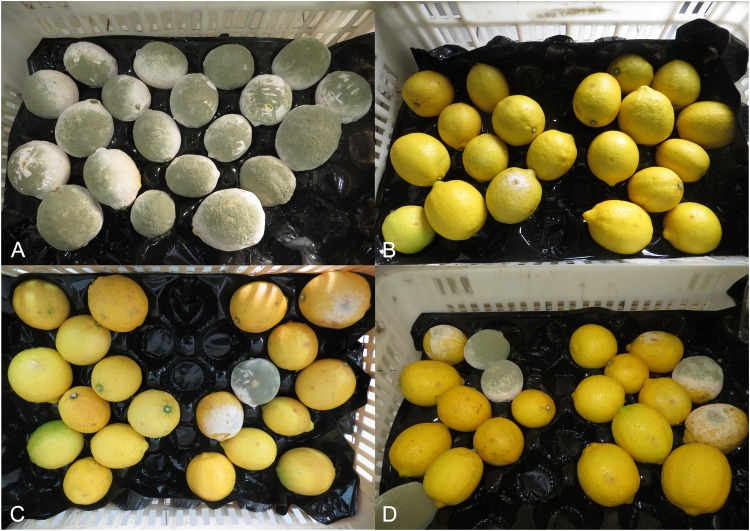
Control of P. digitatum by wounds protection with killer yeasts, after 5 days of incubation.(A) Control lemons, inoculated with pathogen spore suspension. (B), (C) and (D) pretreated lemons with 27, 28 and 56 yeast strains, respectively.